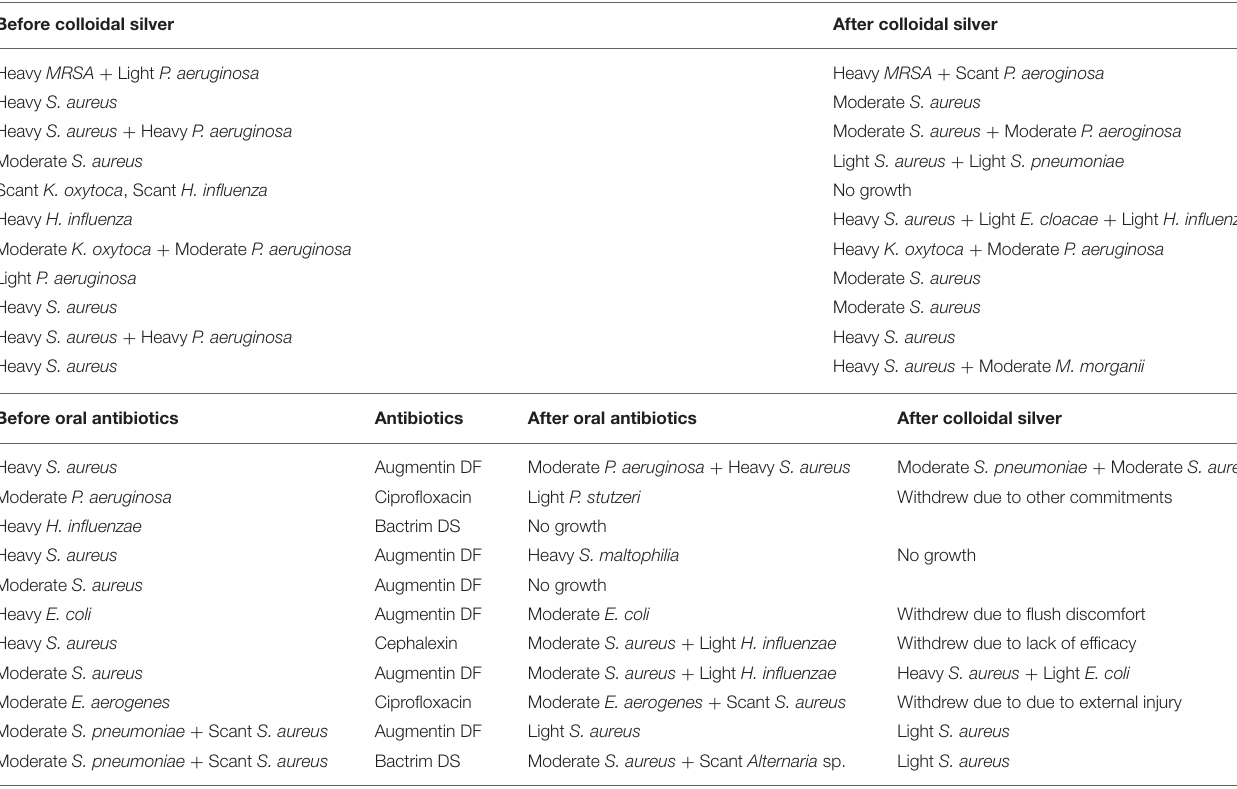
TABLE 3 | Standard semi-quantitative analysis of bacterial load reported as scant, light, moderate or heavy (equivalent to 1 + , 2 + , 3 + , or 4 + ) by laboratory. Before colloidal silver